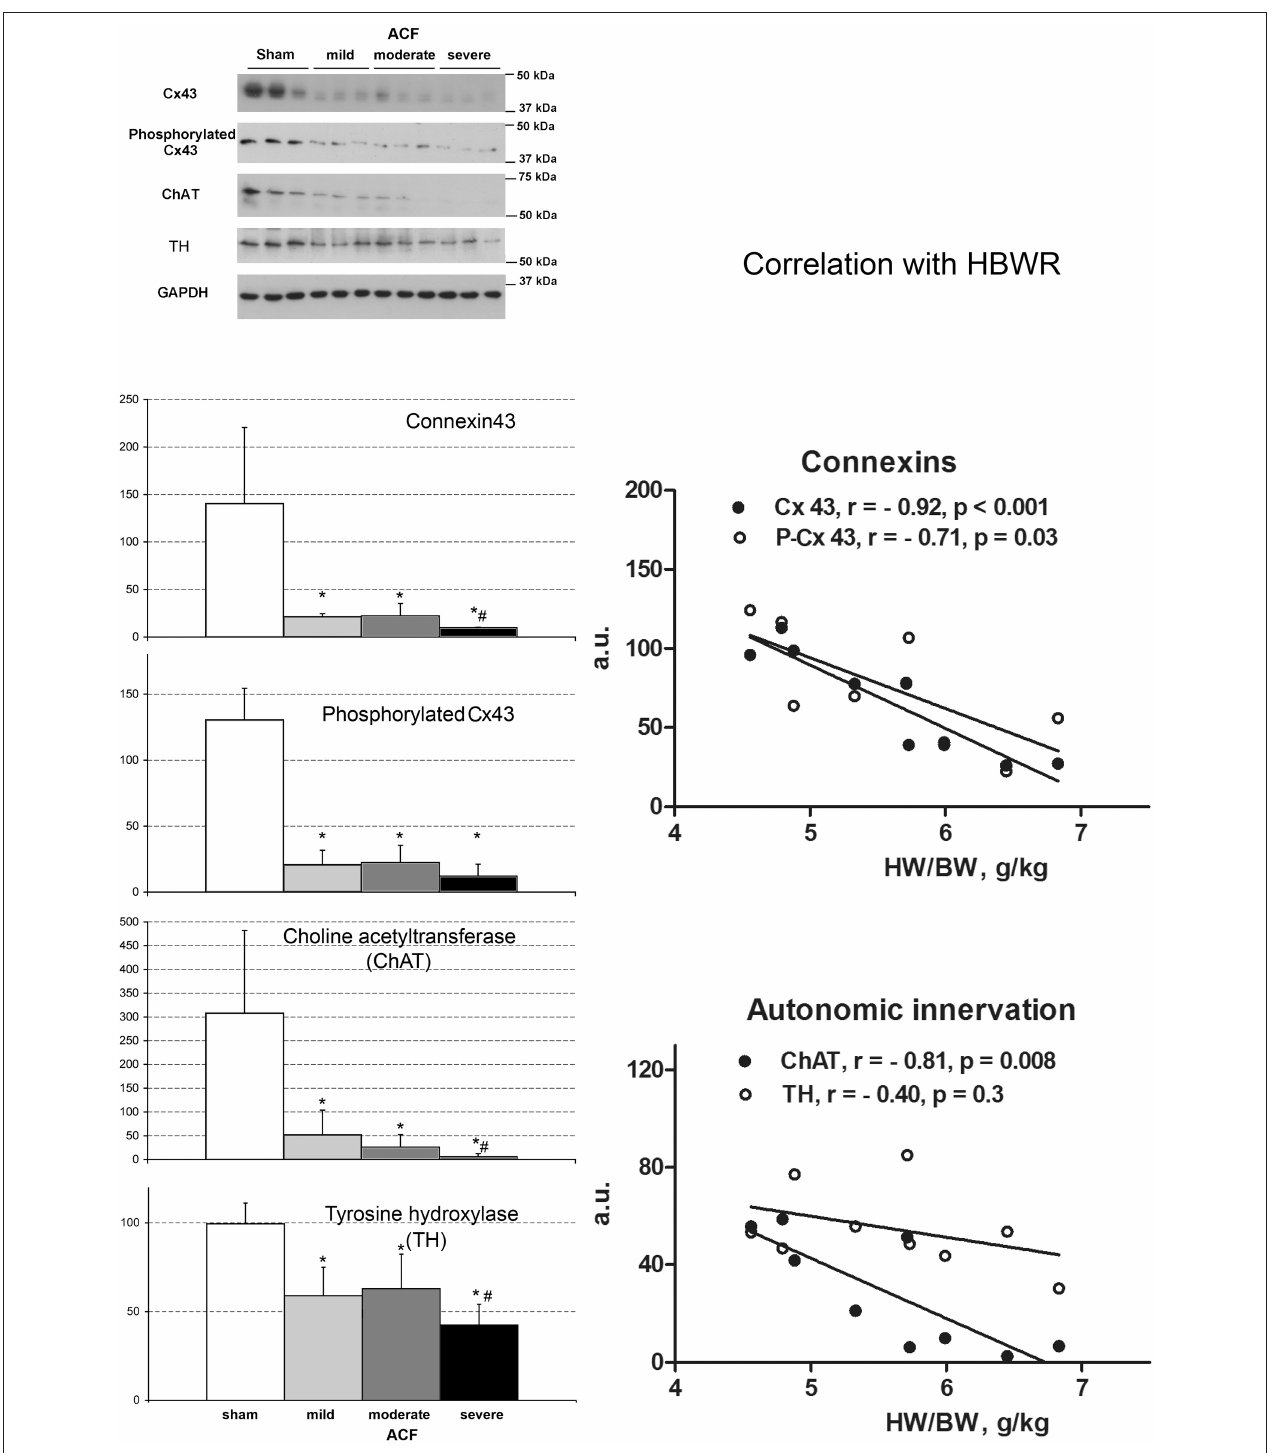
FIGURE 3 | Changes in connexin expression and autonomic innervation markers after ACF. Values are means ± SD, N = 3 samples per group, * p < 0.05 vs. sham, # p < 0.05 vs. less severe ACF groups ( t -test). ChAT, choline acetyltransferase, TH, tyrosine hydroxylase. Graphs show correlation analysis of connexins and autonomic innervation markers with phenotype severity. Amounts of all proteins detected by Western blot decrease with increasing cardiac mass. N = 9 samples from the ACF group (3 for each sub-group), r, Pearson’s correlation coefficient. Line represents linear regression.